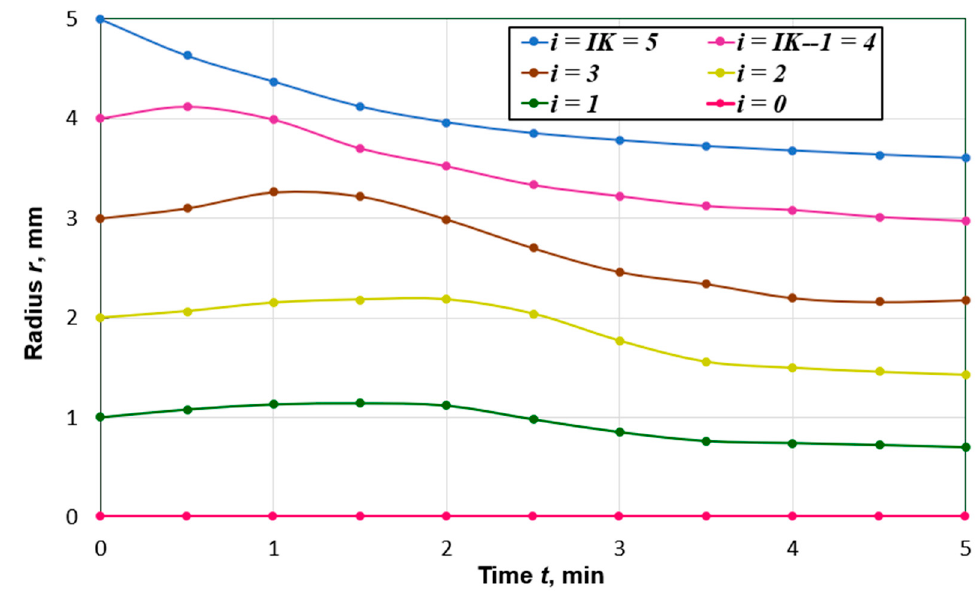
Figure 3. Curves of changes in time of nodal points coordinates r i = f ( r 0 , ) particle, which at the initial moment of time had the value r 0